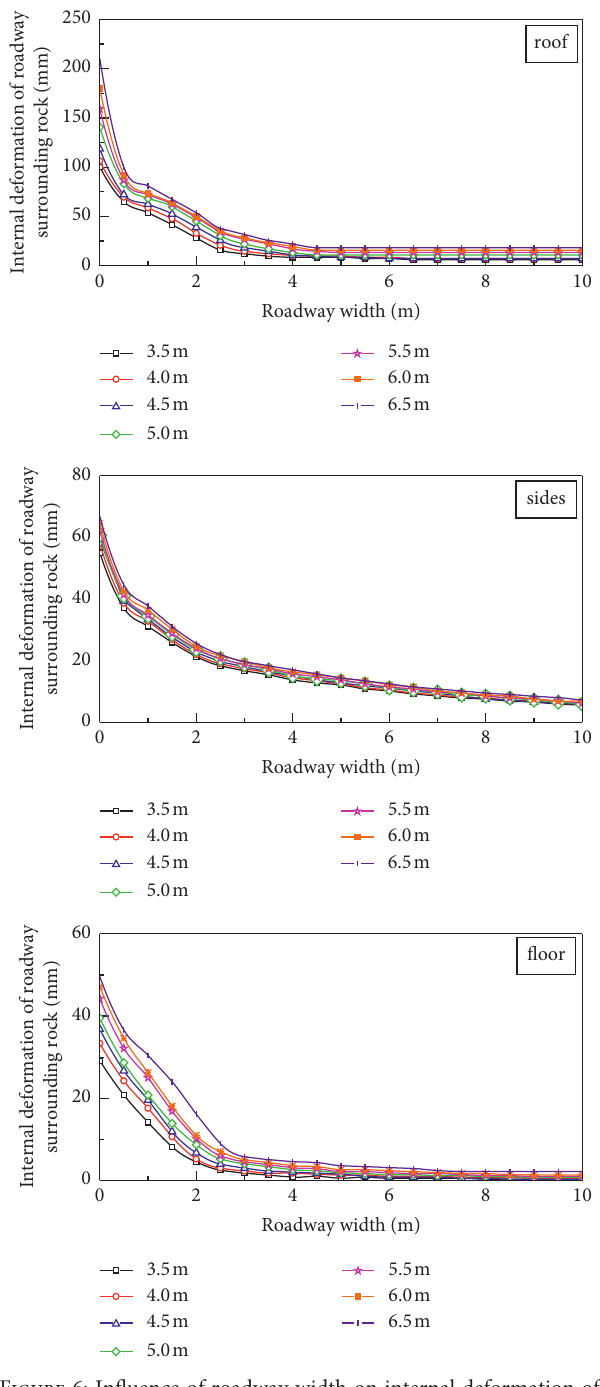
Figure 6: Influence of roadway width on internal deformation of surrounding